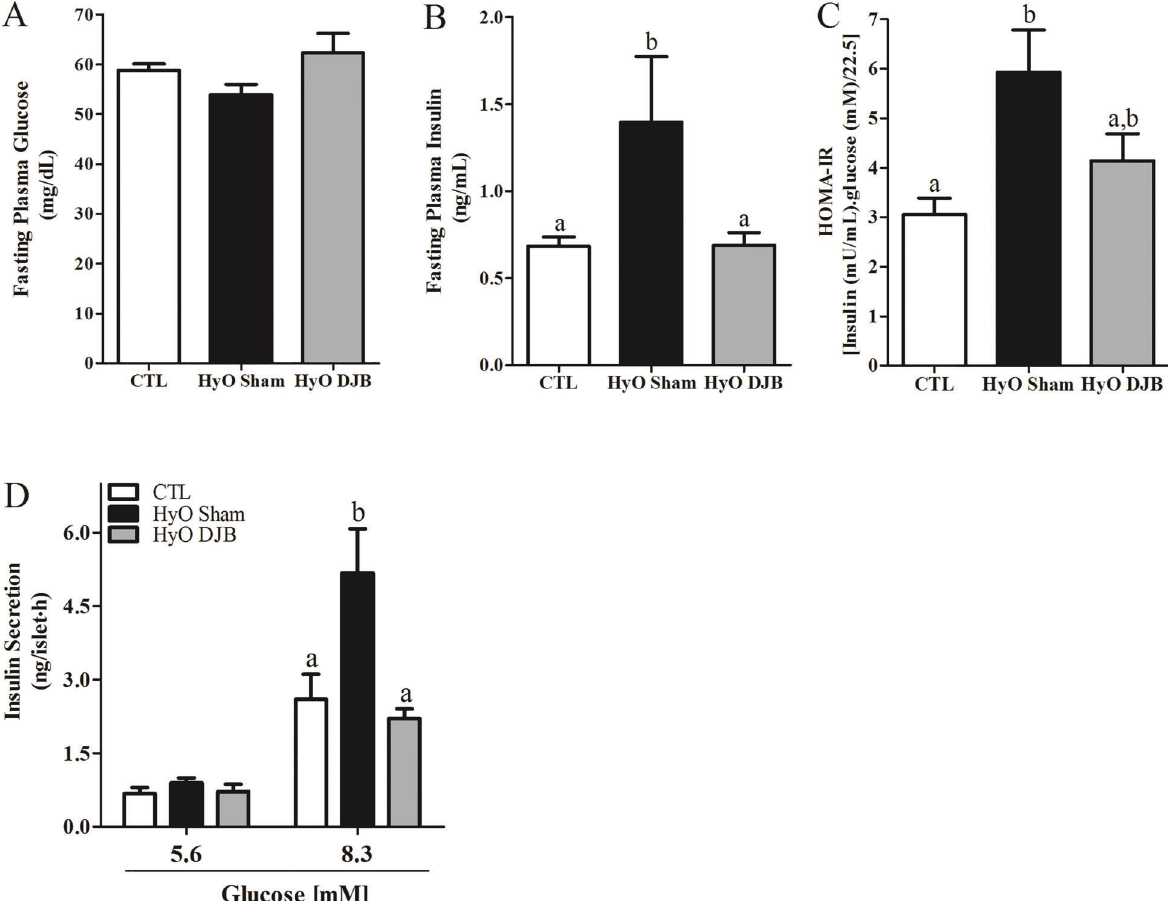
Figure 4. Means ± SEM (n=8 – 14) of A , serum glucose concentration, B , insulin concentration, and C, insulin sensitivity measured by the HOMA-IR in fasted control (CTL), hypothalamic obese (HyO) Sham and HyO with duodenal-jejunal bypass (DJB) rats. D , Glucose-induced insulin secretion in islets isolated from CTL, HyO Sham and HyO DJB rats. Groups of 4 islets were incubated for 1 h in the presence of 5.6 or 8.3 mM glucose. Data are reported as means ± SEM obtained from 8 – 12 groups of islets in two independent experiments with 4 rats per group. P o 0.05, different letters indicate signi fi cant differences (one-way ANOVA followed by the Tukey post-test). Table 3. Morphometric analysis of the pancreas from control (CTL), hypothalamic obese (HyO) Sham and HyO with duodenal-jejunal bypass (DJB) rats. CTL HyO Sham HyO DJB Pancreas weight (% body weight) 1.2 ± 0.08 a 0.8 ± 0.07 b 1.3 ± 0.07 a Islet area ( m m 2 ) 32384 ± 1569 a 22884 ± 887 b 19979 ± 1012 b b -cell area ( m m 2 ) 22466 ± 1068 a 15082 ± 570 b 13432 ± 683 b a -cell area ( m m 2 ) 6913 ± 532 a 5319 ± 292 b 4776 ± 340 b Total islet area (% pancreas area) 0.9 ± 0.07 a 1.4 ± 0.02 b 0.7 ± 0.05 a Total b -cell area (% pancreas area) 0.7 ± 0.07 a 1.0 ± 0.08 b 0.5 ± 0.05 a Total a -cell area (% pancreas area) 0.3 ± 0.07 0.4 ± 0.05 0.2 ± 0.02 Islet number per section 159 ± 29 252 ± 51 150 ± 11 Number of islets analyzed 635 1007